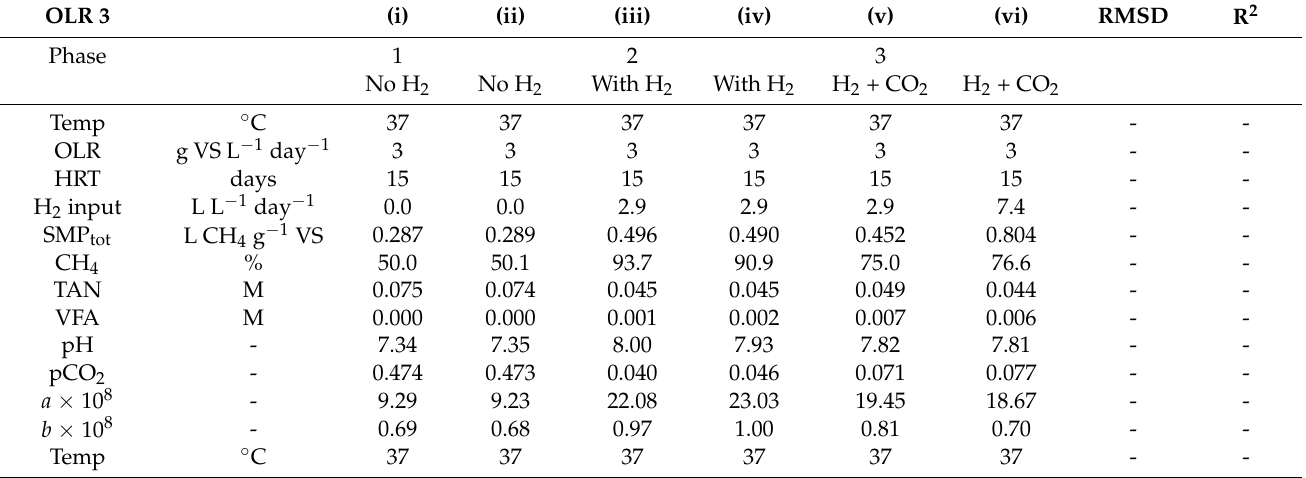
Table 3. Performance of Equations A and B and phosphate adjustment for data from Tao et al.